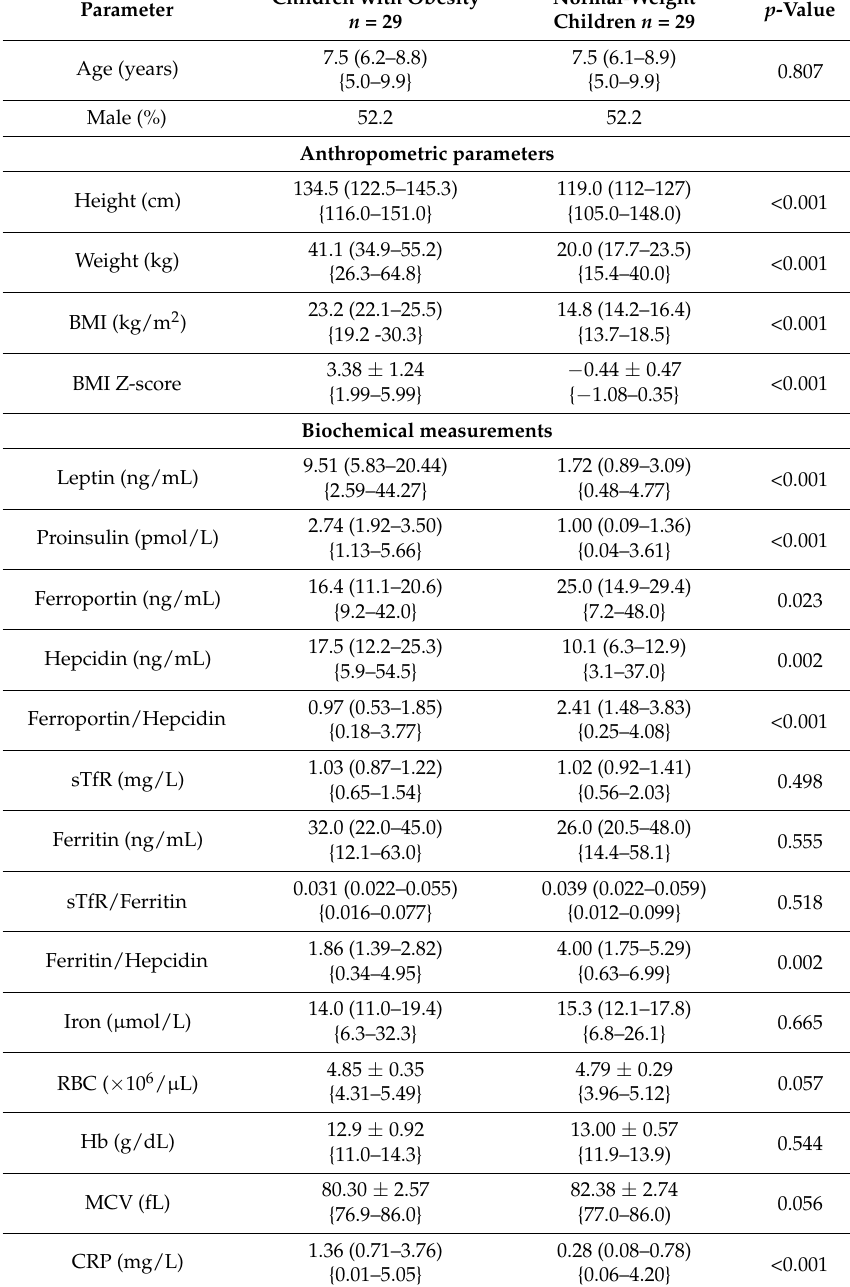
Table 2. Clinical and biochemical characteristics in prepubertal children with obesity and in normal-weight children (pair-matched